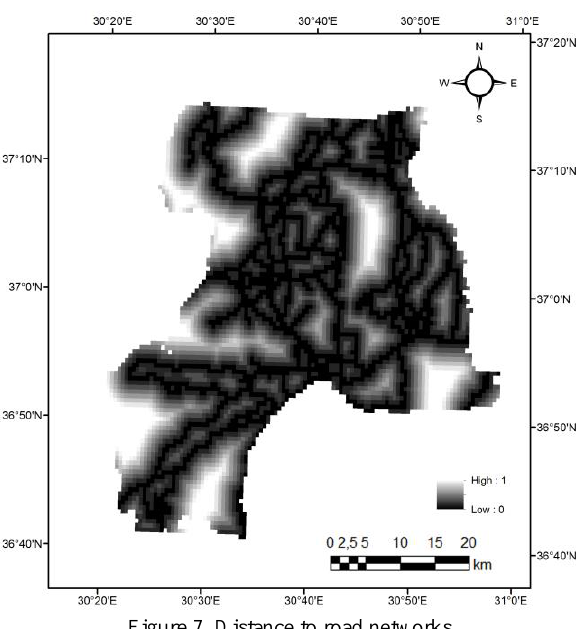
Figure 7. Distance to road